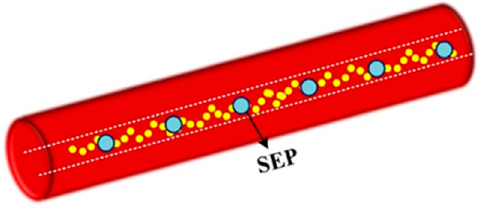
Figure 6. Schematic diagram of discrete scattering ‐ enhanced fiber.